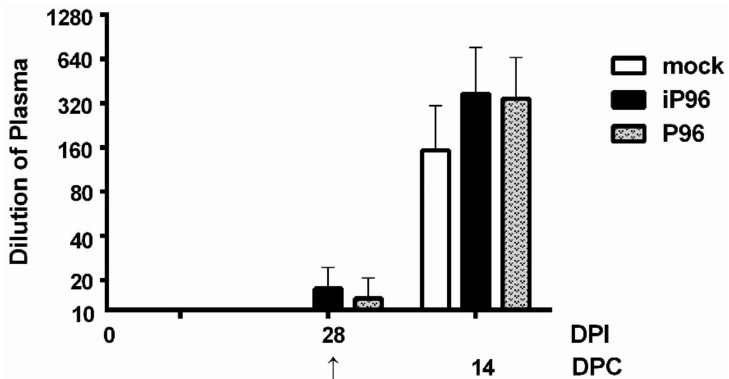
Figure 8. The plasma neutralizing antibody titers in piglets inoculated with the iPEDVPT-P96 virus (black), the PEDVPT-P96 virus (gray), or mock-inoculated (white) at 0 and 28 days post-inoculation (DPI) and at 14 days post-challenge (DPC) after re-challenge or challenge with the PEDVPT-P5 virus. Each group consisted of 5 piglets. The arrow indicated the time point (28 DPI or 0 DPC) of challenge with PEDVPT-P5 virus. Data were expressed as the mean ± standard deviation. Statistically significant differences between each group were examined using a two-way ANOVA by